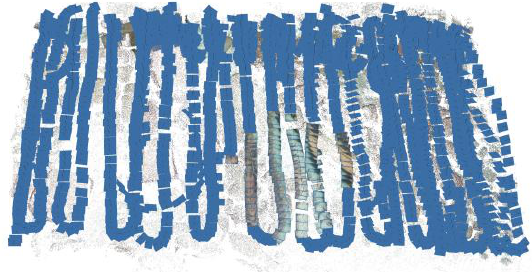
Figure 7. Methods of capture of the surface model (processing by Mohamed Abdelaziz)